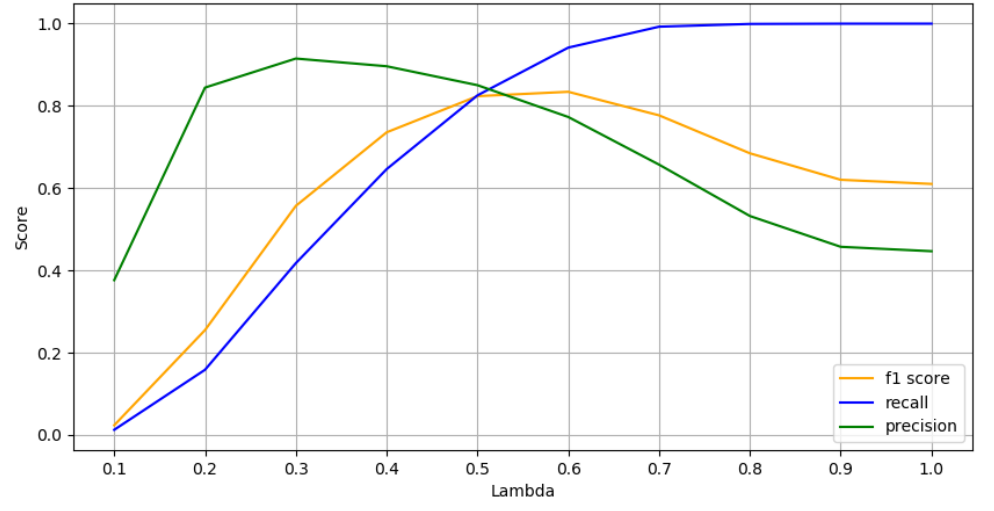
Figure 11. The accuracy variation of entropy-based filtering as λ is